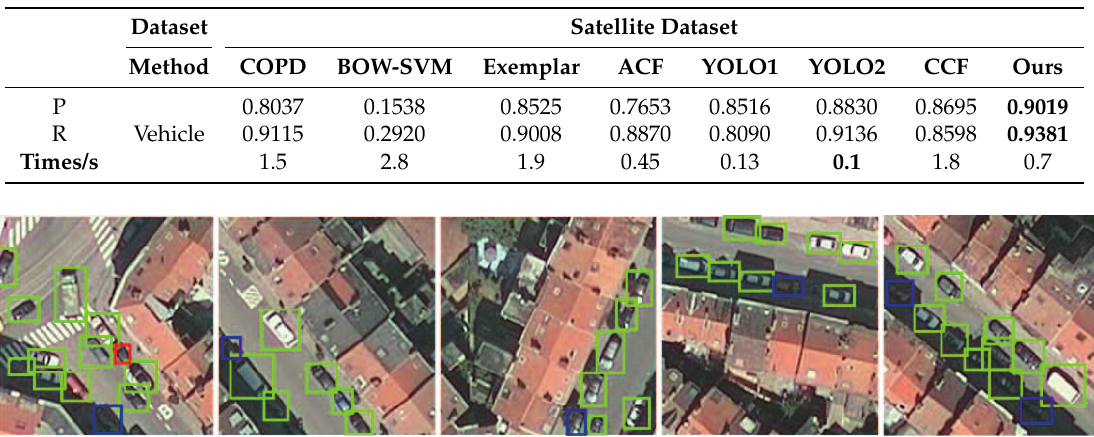
Figure 10. A showcase of MsRi-CCF with the satellite dataset (false detection in red, true positive in green, and missed detection in